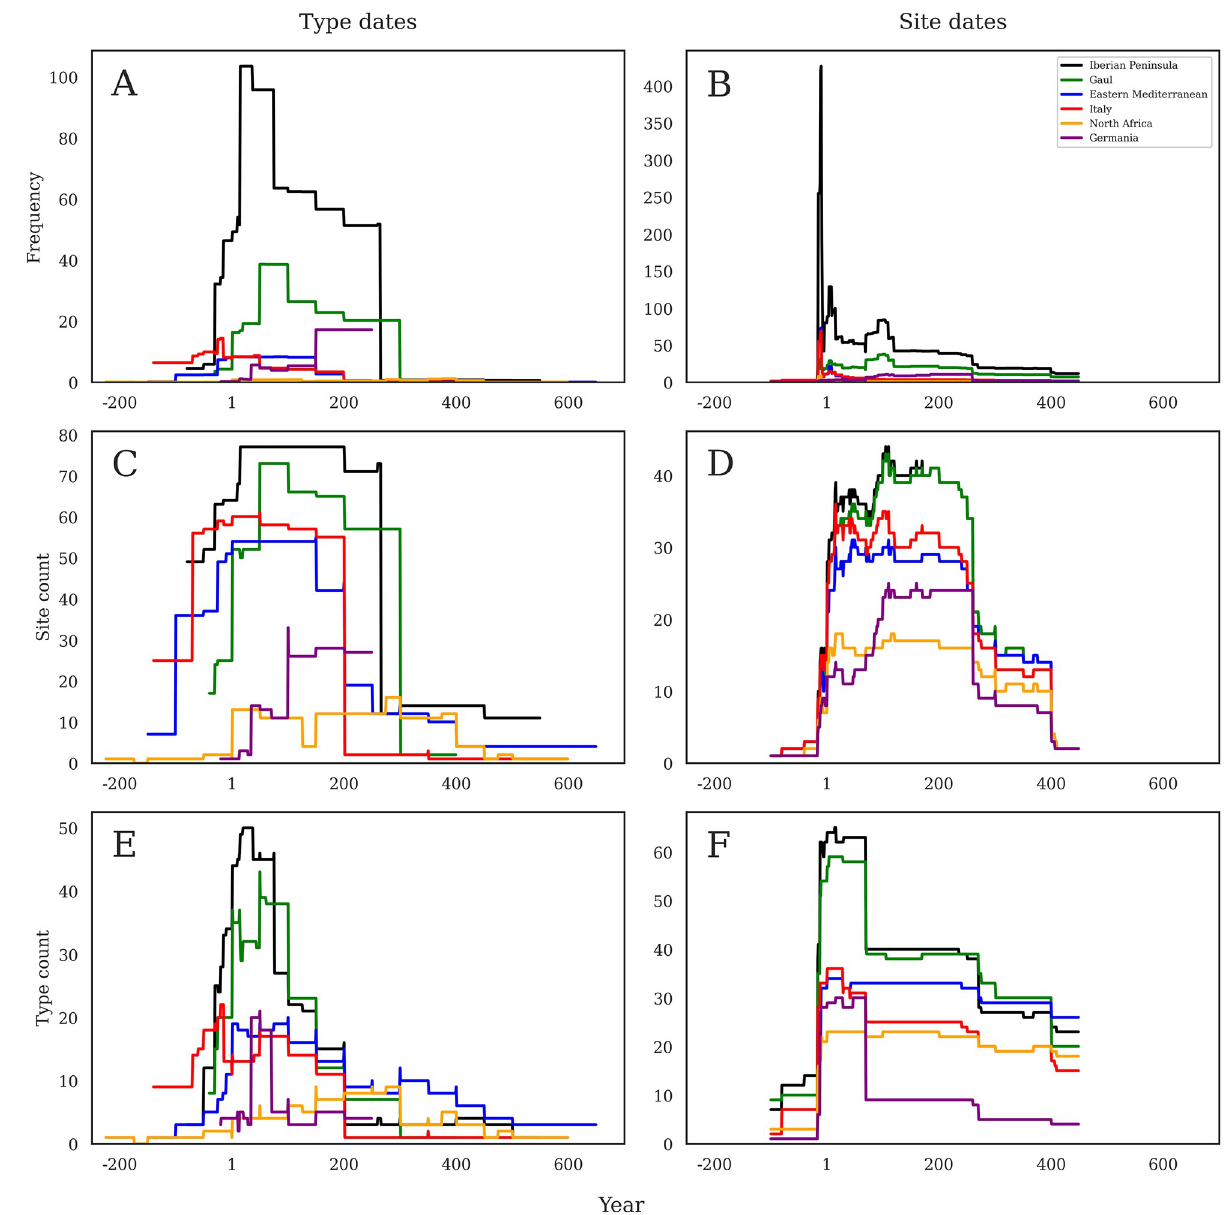
Fig 5. a-f: Amphora origins through time. Comparison of six main amphorae production regions across the three different methods of analysis according to production dates (left) and consumption dates (right). Note that Y axes are not constant.